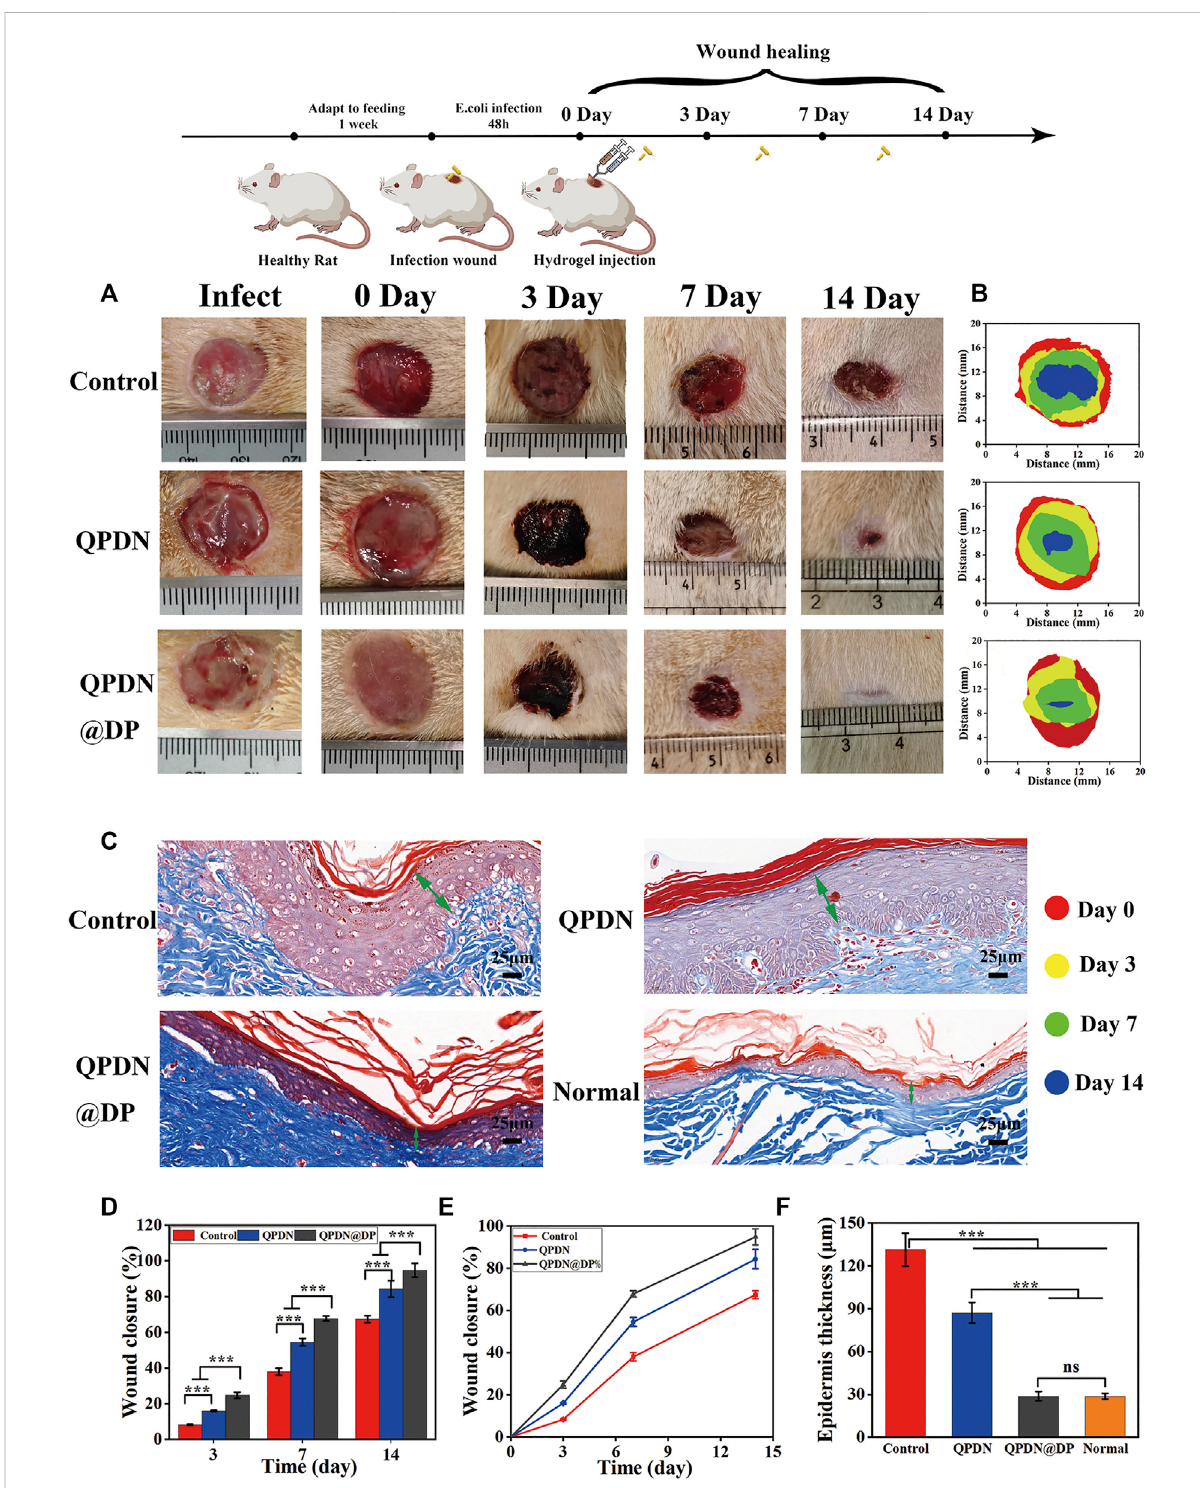
FIGURE 6 Repair of animal model of wound after perianal infection. (A) Schematic illustration for constructing continuous infected wound and healing process; Representative photographs of the continuous infected wound healing process of rats under different treatments ( n = 3). (B) Wound fractions healed by different treatments on days 0, 3, 7, and 14 ( n = 3). (C) Masson staining of wounds on day 14, green arrows represent epidermal thickness (Scale bar = 25 μ m) (D,E) Quantitative analysis of continuous infected wound area in each group ( n = 3). (F) Quantitative analysis of epidermal thickness in each group on day 14 in Masson staining ( n = 3). Mean ± SD ( n = 3). * p < 0.05, ** p < 0.01, *** p <